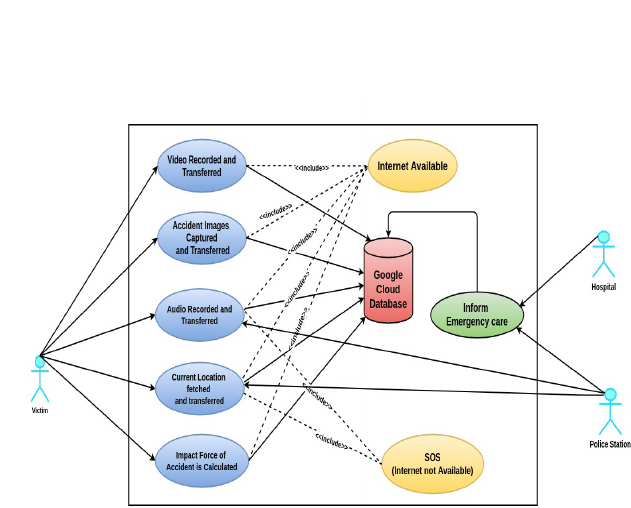
Figure 11. USE CASE